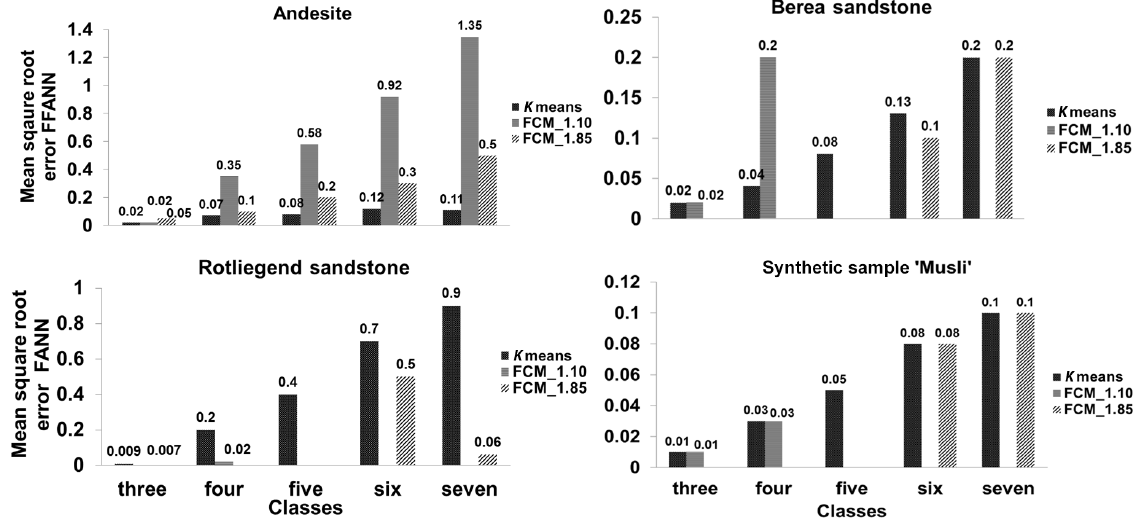
Figure 7. Mean square root error values of feed forward artificial neural network (FFANN) obtained for respective samples. FFANN was trained using segmented datasets of k -means, fuzzy c -means with a membership function of 1.10 and